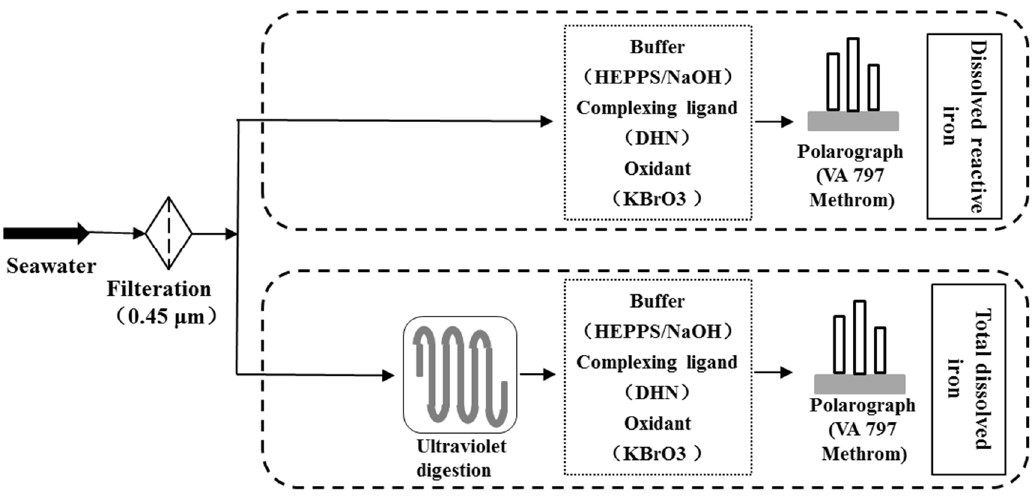
Figure 2. Schematic diagram of the iron speciation analysis in coastal seawater .